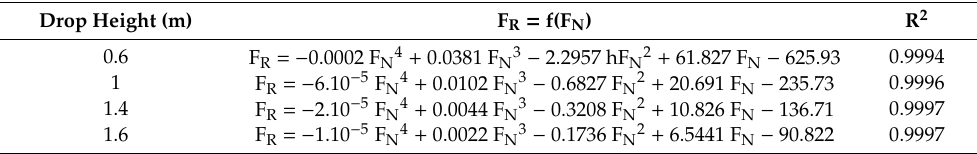
Figure 17. Correlation between the impact force F R and the tensile force F N at the drop hammer weight of 100 kg without the support system. Table 11. Correlation between the impact force F R and the tensile force F N at the drop hammer weight of 90 kg without the absent support system.